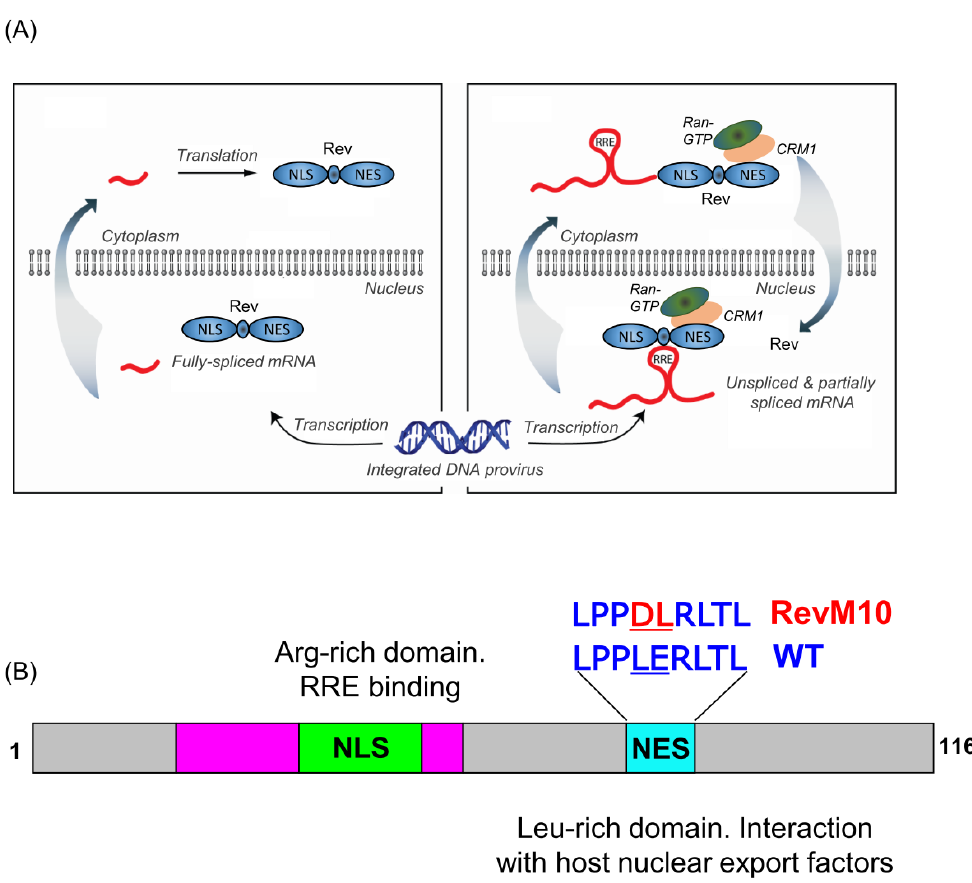
Figure 1. ( A ) Functional requirement of the HIV RRE: Early in the viral lifecycle, fully spliced viral RNAs are exported from the nucleus in a Rev / RRE-independent manner. Among these, Rev mRNA are translated and Rev is imported into the nucleus. In the late phase of the lifecycle, nuclear RRE-containing RNAs recruit Rev and cellular nuclear-export machinery, allowing them to circumvent splicing and transit to the cytoplasm, where they are either translated or packaged into assembling virions ( B ) Organization of the 116 aa HIV-1 Rev and amino acid changes in the trans-dominant M10 variant. NLS; nuclear localization signal, NES, nuclear export signal. Pink areas flanking the NLS represent Rev oligomerization